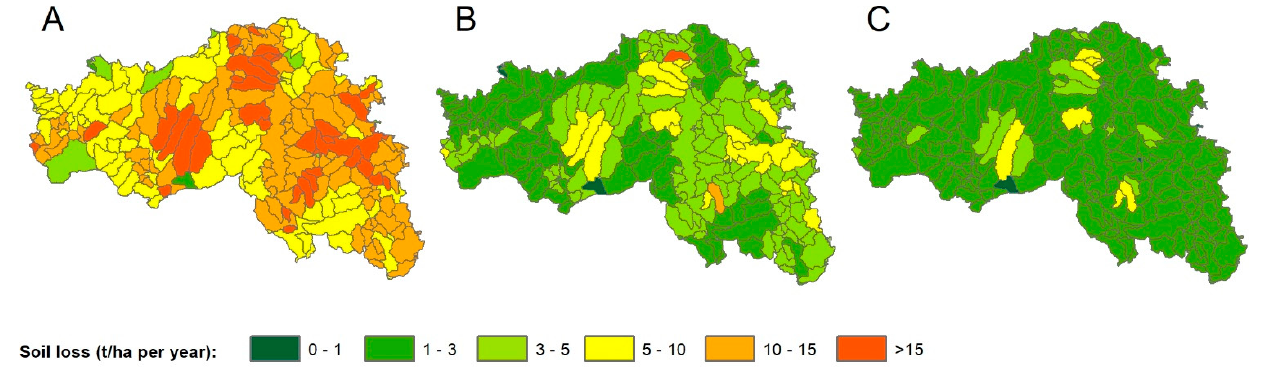
Figure 6. Modeled erosion-induced soil losses in the studied river basins of Belgorod Oblast: ( A )—for bare (clean) fallow conditions; ( B )—for the actual composition of crops; ( C )—for ALAS projects.